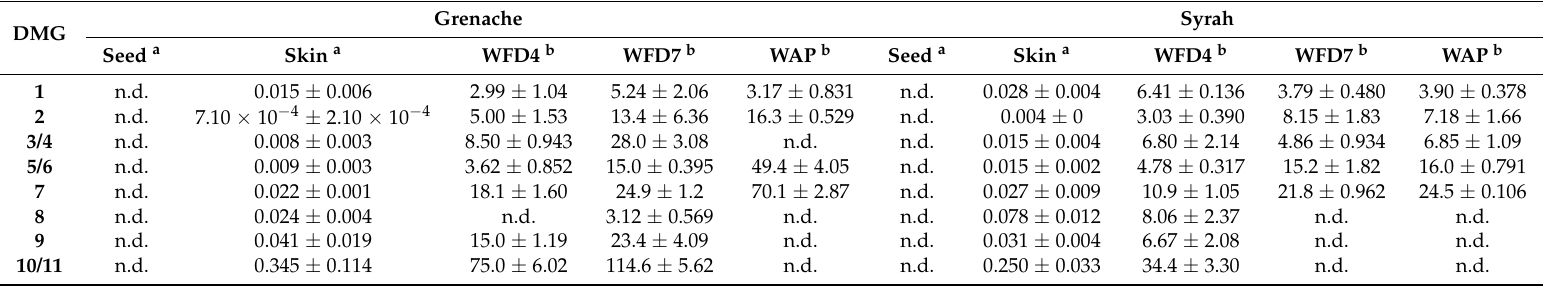
Table 2. Contents of dimeric (epi) catechin monoglycoside (DMG) isomers measured in grape seed and skin, and during winemaking at WFD4, WFD7, and